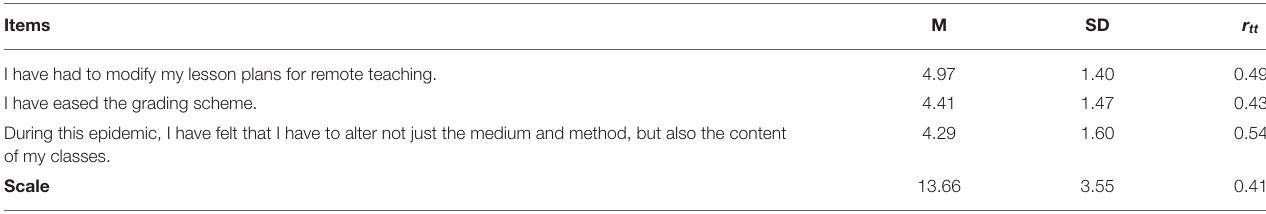
TABLE A2 | Evaluation uncertainty scale–means, standard deviations, and item-total score-corrected correlations of the items ( N = 1,944, α = 0.73, ω h = 0.75, λ 6 = 0.68, ρ = 0.98). Items M SD r tt